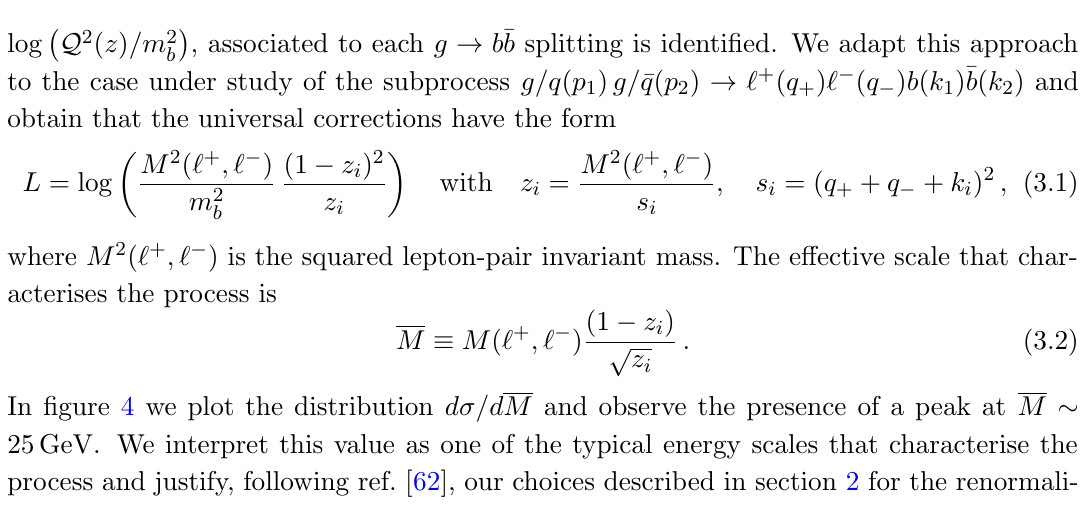
Figure 4 . Event distribution, in ‘ + ‘ (cid:0) b (cid:22) b production, with respect to the variable M de(cid:12)ned in eq. (3.2). The red arrow corresponds to the peak of the